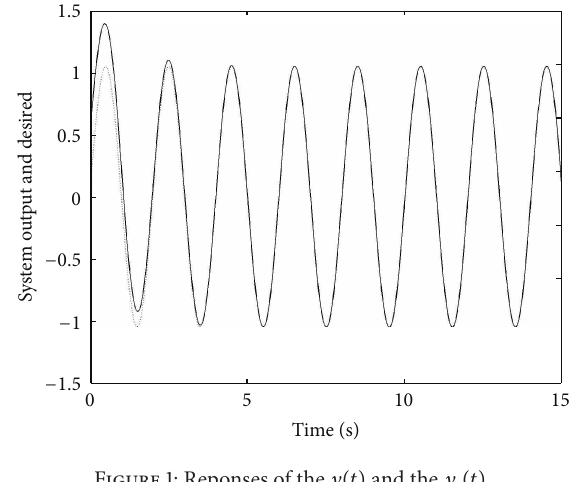
Figure 1: Reponses of the 𝑦(𝑡) and the 𝑦 𝑟 (𝑡) .